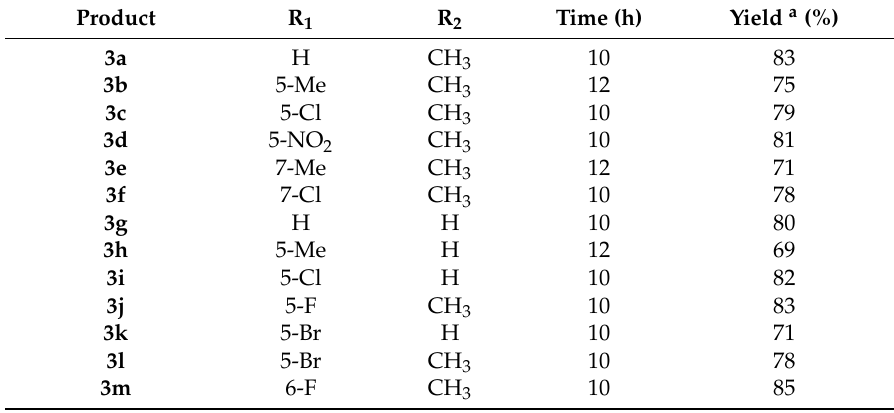
Table 2. Synthesis of spiro[indoline-3,9 ′ -xanthene]trione 3 .